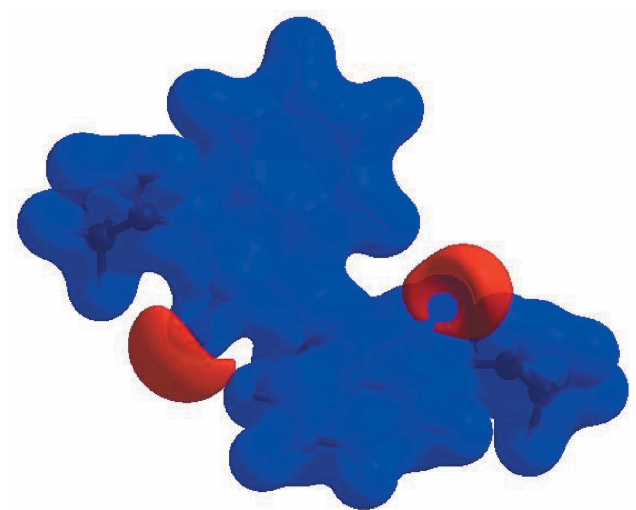
Figure 4 View of the three-dimensional Hirshfeld surface of the title compound plotted over electrostatic potential energy in the range (cid:5) 0.0500 to 0.0500 a.u. using the STO-3 G basis set at the Hartree–Fock level of theory. Hydrogen-bond donors and acceptors are shown as blue and red regions, respectively, around the atoms corresponding to positive and negative